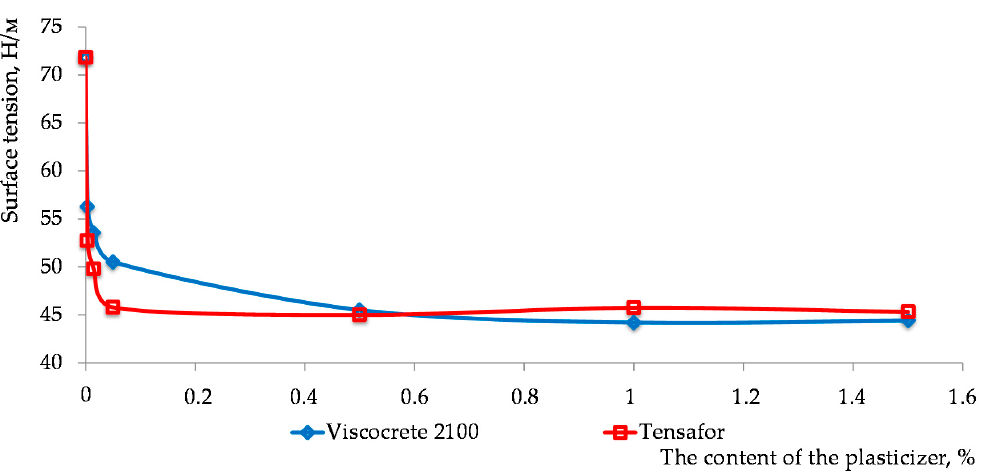
Figure 3. The dependency of surface tension change on the plasticizer’s concentration.